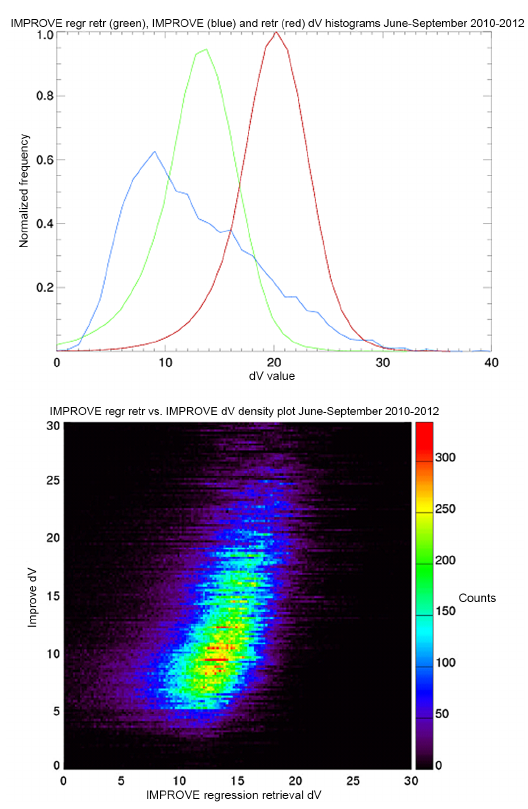
Figure 4. Top panel: histograms of collocated d V values for IM- PROVE regression (monthly bias-corrected) retrieval (green), IM- PROVE (blue), and ABI Retrieval (red) for June–September 2010– 2012; bottom panel: density plot of collocated d V values for IM- PROVE regression (monthly bias-corrected) retrieval versus IM- PROVE for June–September